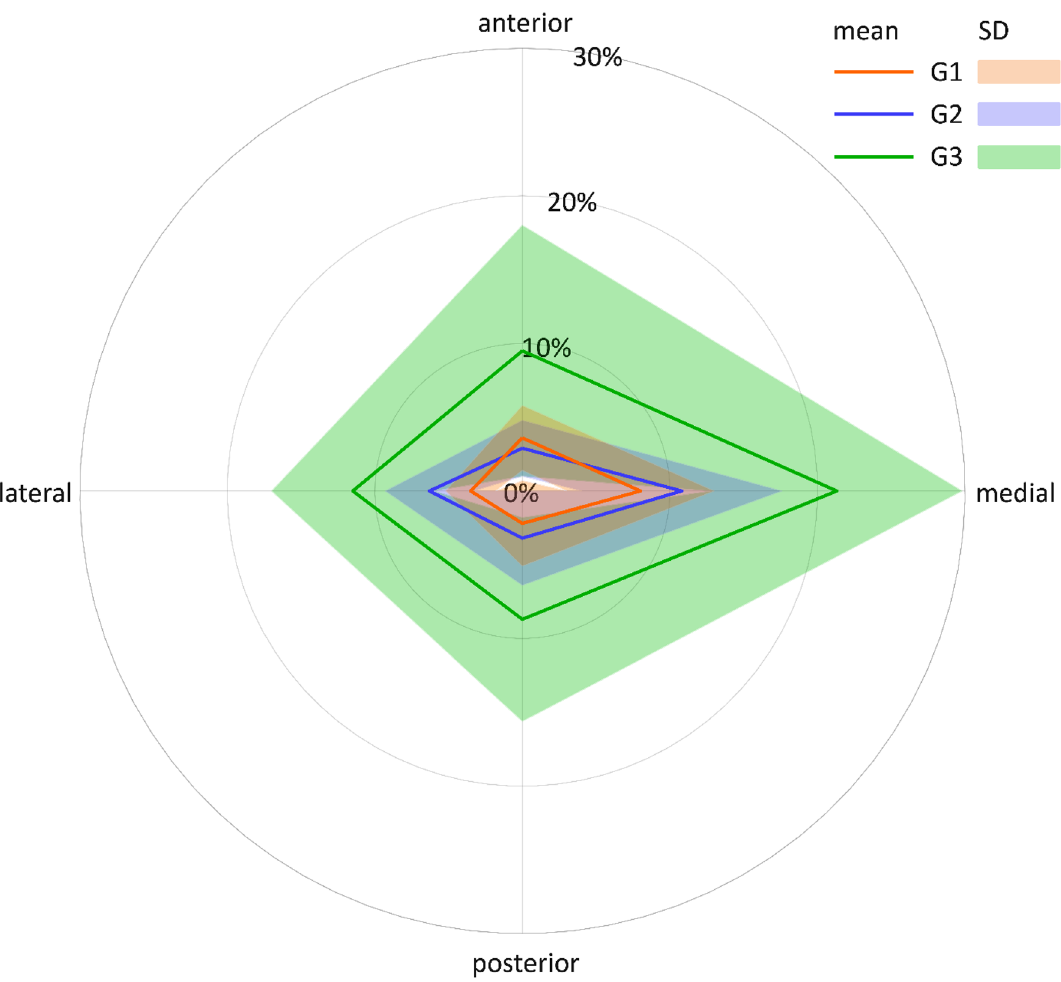
Figure 7. Net diagram visualizing the eccentricity of reaming in the third eight of the femora from the three study groups G1, G2 and G3 in terms of mean value and standard deviation (SD) of the relative volume decrease (%DecVol) in each of the four quarters (anterior, medial, posterior and